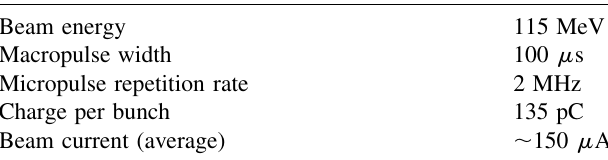
TABLE II. Experimental beam conditions.